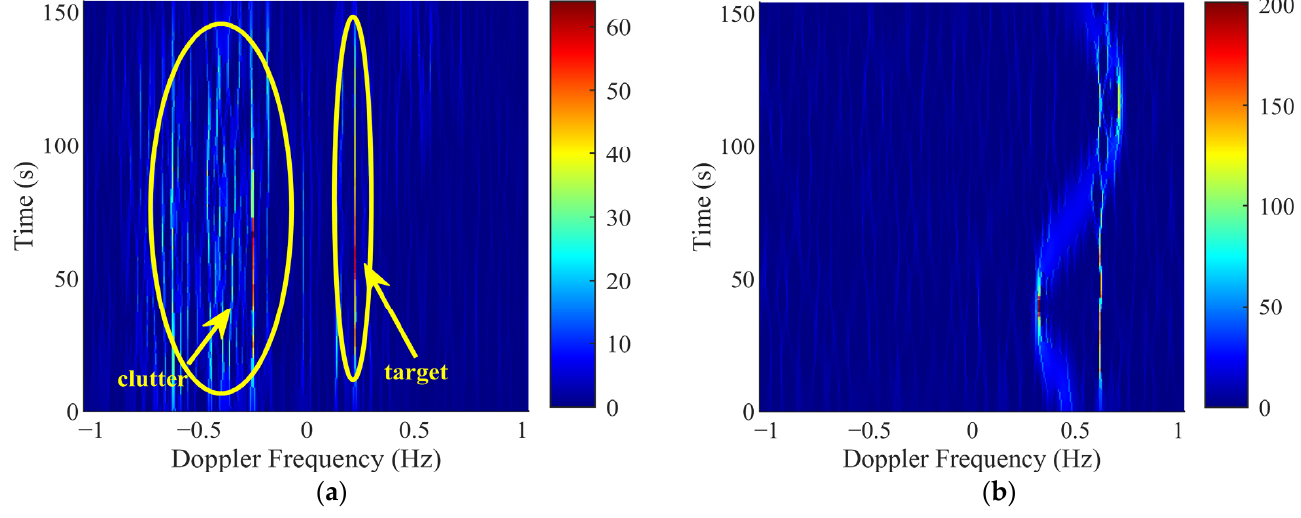
Figure 1. The FSST results map of clutter and target echoes. ( a ) A successful separation between target and clutter. ( b ) Target interfered by clutter.